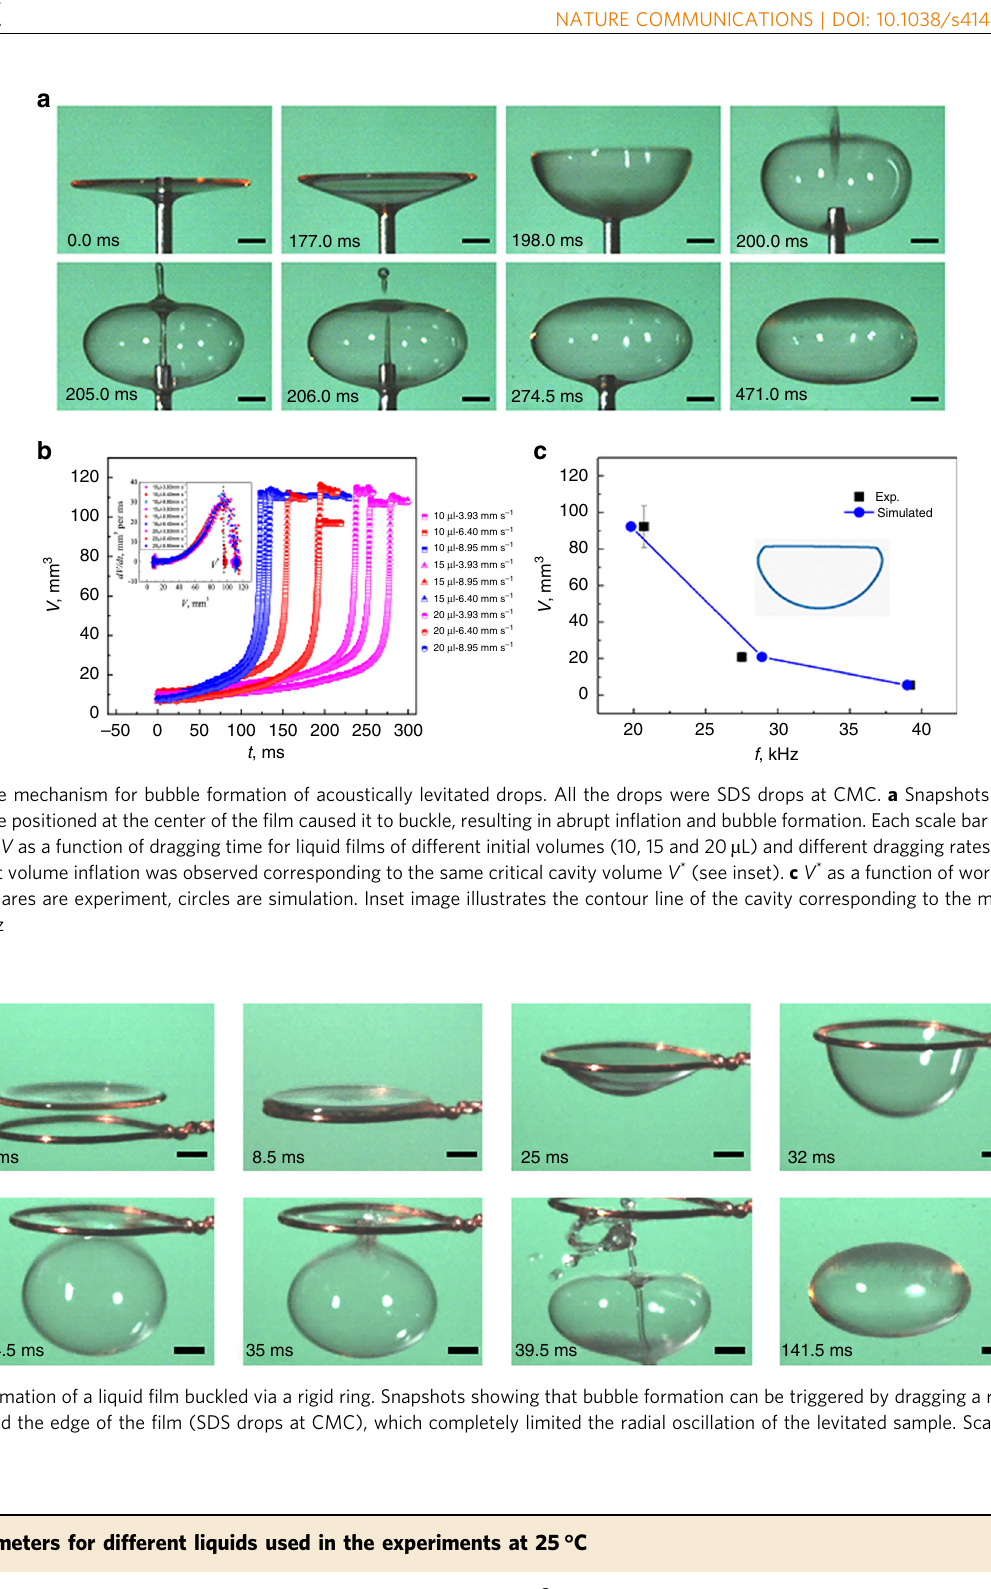
Table 1 Parameters for different liquids used in the experiments at 25 °C Liquid